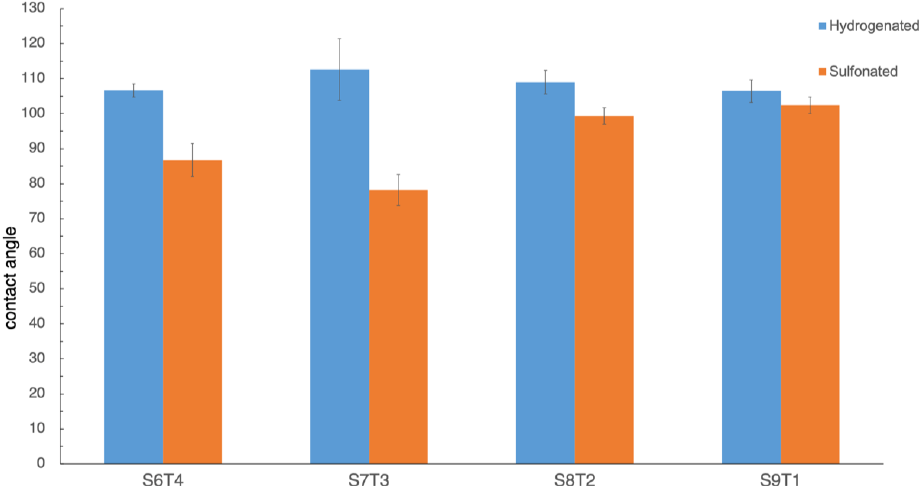
Figure 4. Contact angle results of the hydrogenated and sulfonated hydrogenated SIS samples.